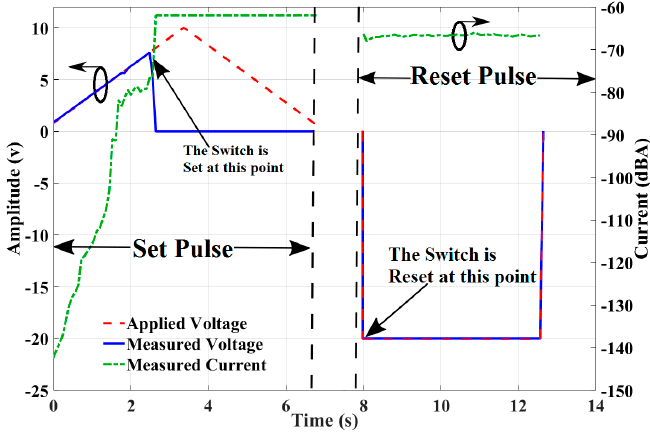
Figure 5. Direct current (DC) pulses used to operate the switch.